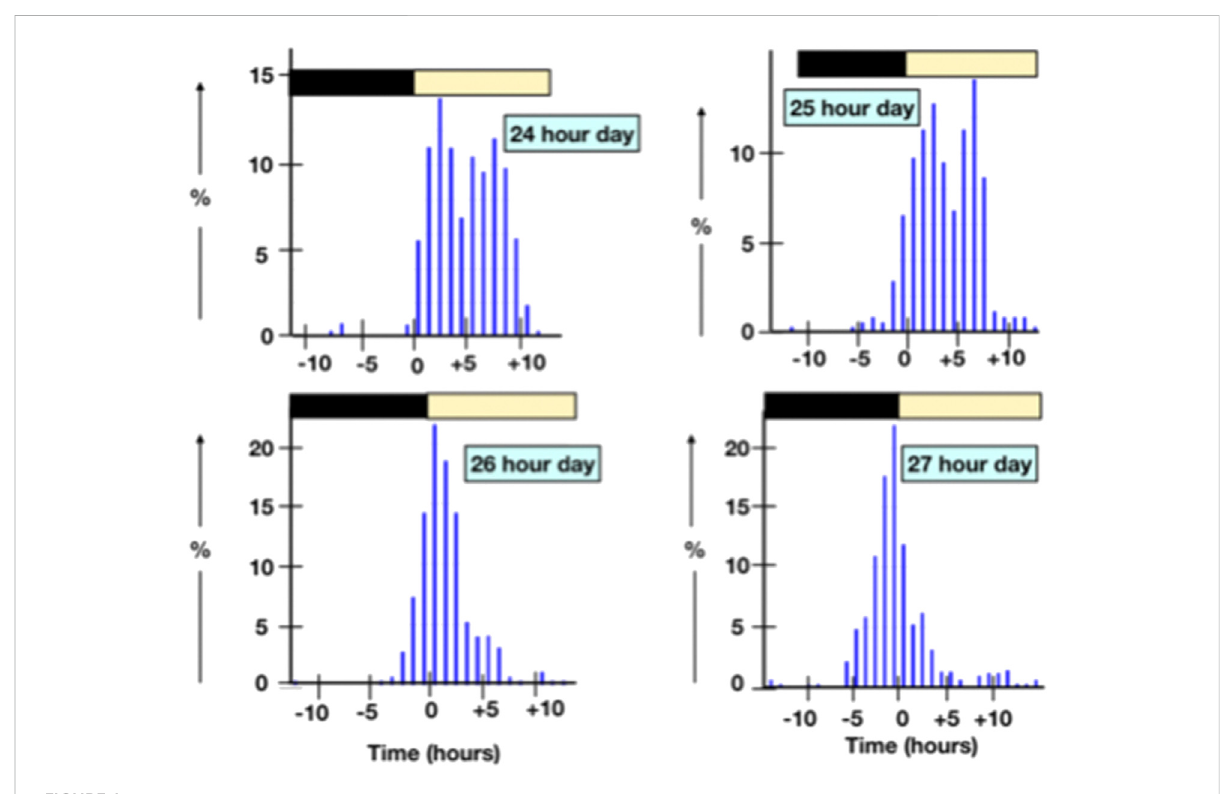
FIGURE 1 Shifts in the time of oviposition with ahemoral light cycles.